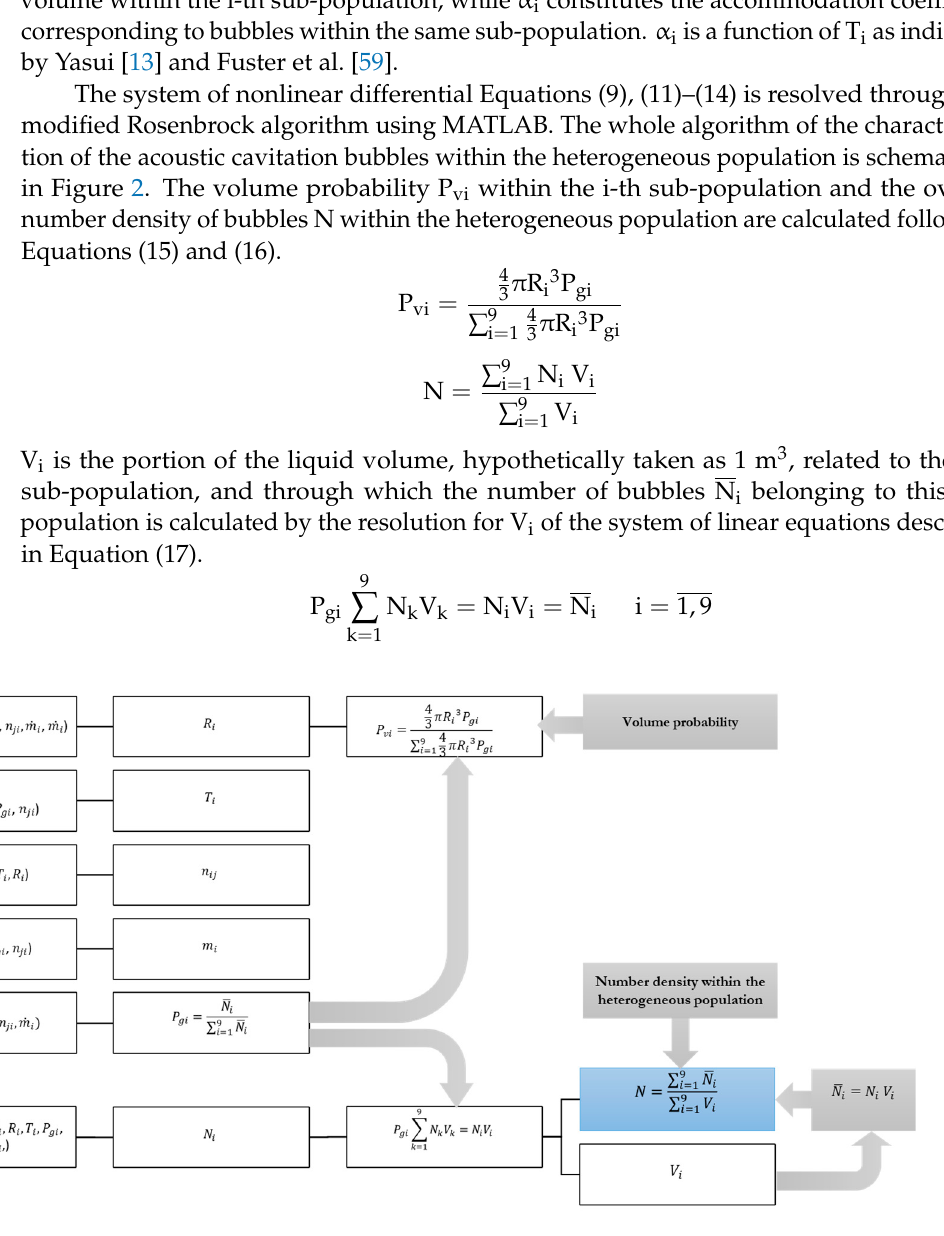
Figure 2. Schematic illustration of the algorithm applied for characterization of the heterogeneous population of acoustic cavitation bubbles.